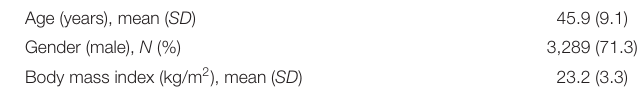
Frontiers in Digital Health |